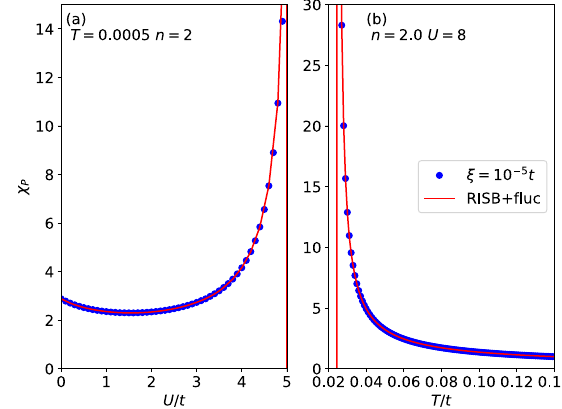
FIG. 10. Bare pairing interaction in the particle-hole channel Γ bare [Eq. (K1)] as a function of Coulomb interaction U and J ¼ ph U= 4 for filling n ¼ 2 . 8 , 2.6, 2.4, 2.2, 2.0, 1.8, 1.6 at temperature T ¼ 0 . 0005 t .